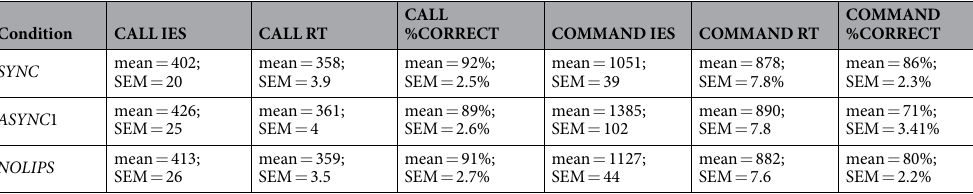
Table 1. Performance Results. Mean and standard error of the mean for the different conditions and performance variables (Inverse Efficiency Score (IES); Response Time (RT), and % of Correct